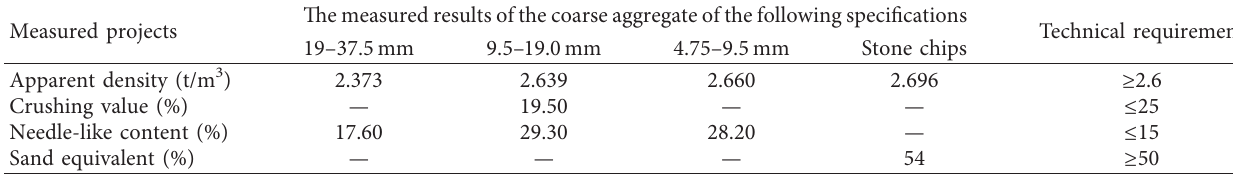
Table 2: Technical indicators of the aggregate.